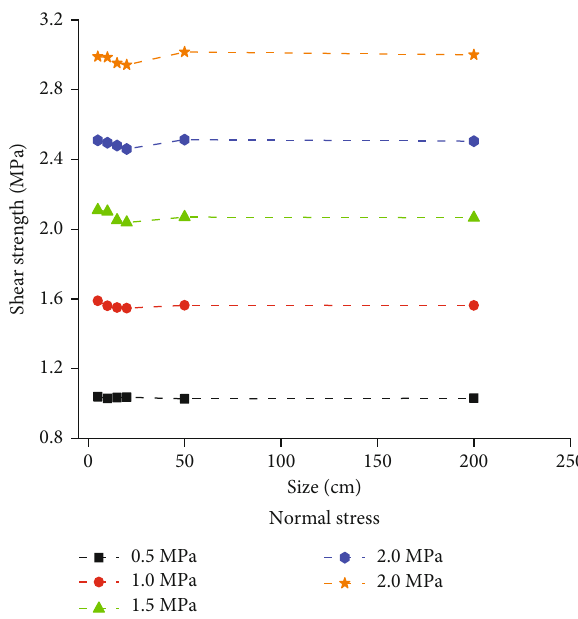
Figure 6: Relationship between shear strength and size of models subjected to di ff erent normal stress.